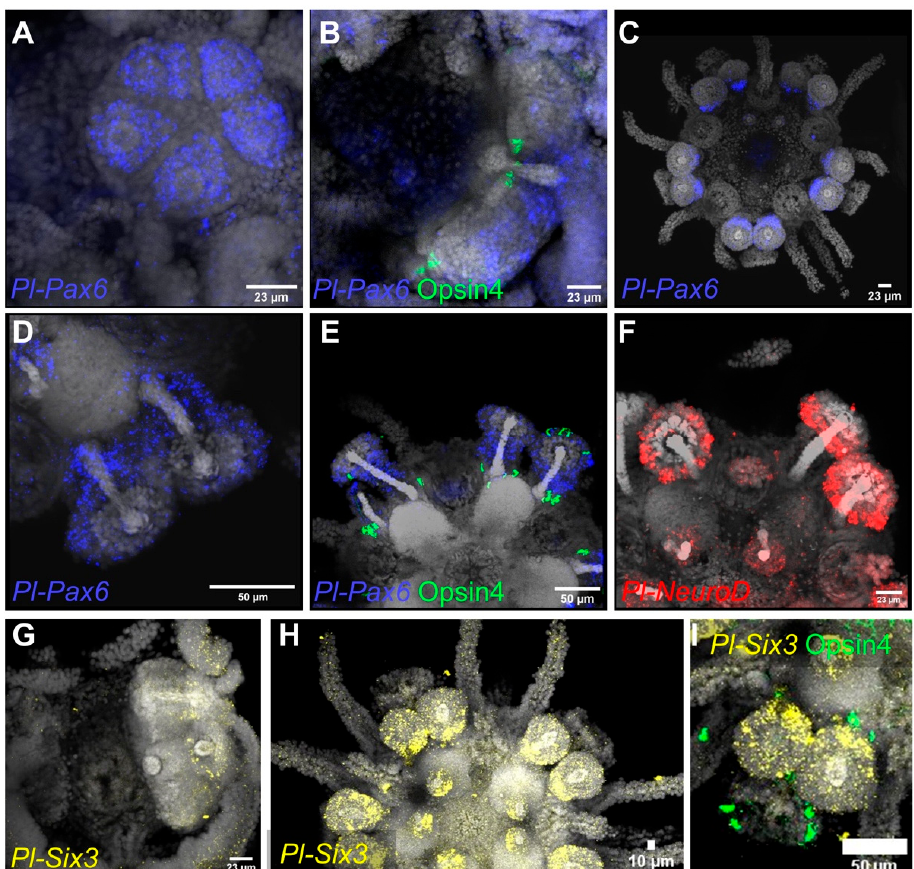
Figure 5. Retinal transcription factors pax6 , neuroD1 and six3 RNA: expression in whole mount mature rudiments and juveniles. ( A – E ) FISH using a specific antisense probe against Pl-pax6 at rudiment ( A,B ) and juvenile ( C – E ) stages. In B and E, FISH are also paired with IHC detection of Opsin4. ( F ) FISH detection of the neuroD transcripts at juvenile stage. ( G – I ) FISH using an antisense probe for six3 at rudiment ( G ) and juvenile ( H , I ) stages. In I, FISH is paired with IHC for Opsin4. DAPI was used to visualize nuclei (gray). Orientation: ( A ), the specimen is viewed from the top; ( B , G ) the specimens are viewed from the side; ( C – F , H , I ) juveniles are in oral view.